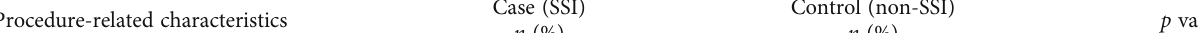
Table 2: Procedure-related characteristics of patients with SSI following cesarean section compared with control group. Procedure-related